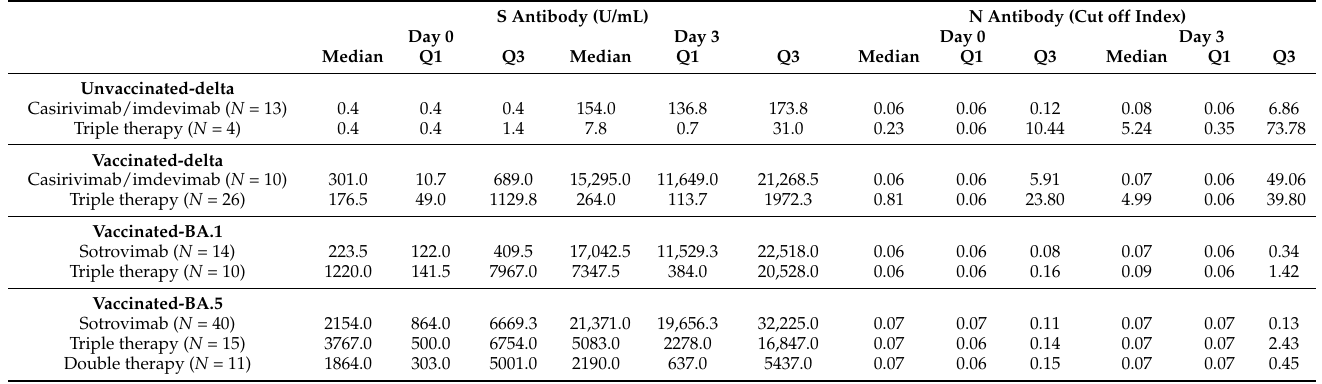
Table 4. Titers of anti-SARS-CoV-2 S and N antibody according to treatment and vaccination status. S Antibody (U/mL) N Antibody (Cut off Index) Day